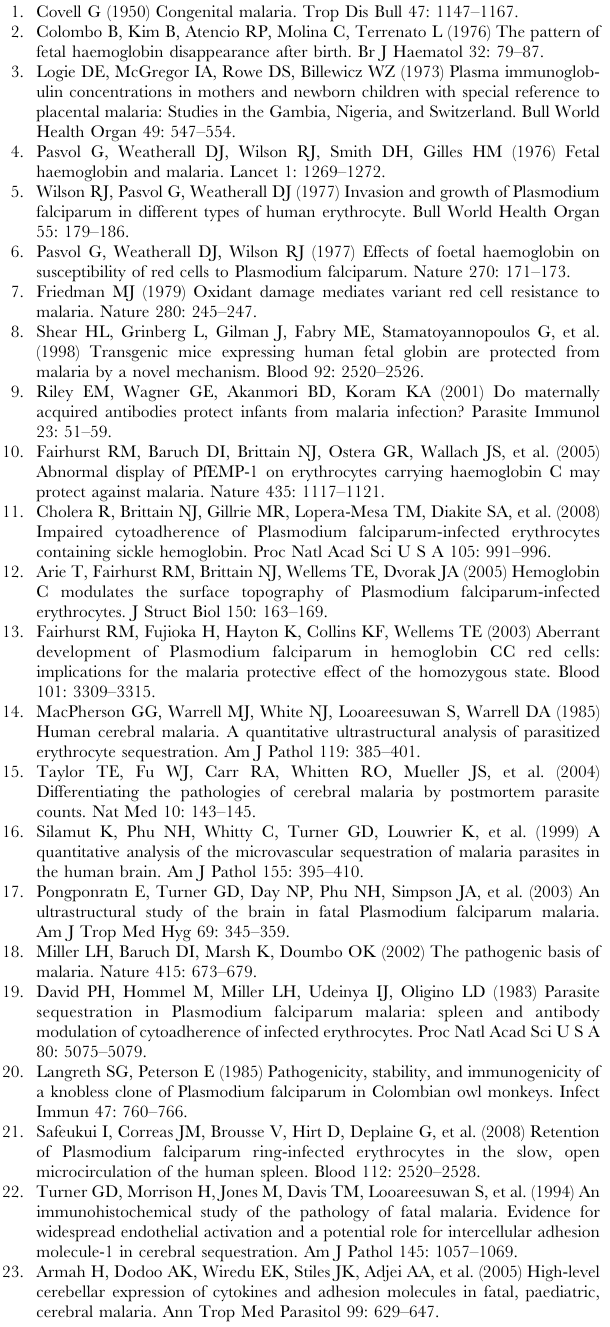
Table S2 Relative adherence of parasitized AA and CB red blood cells (RBCs) to microvascular endothelial cells (MVECs) in the presence of nonimmune IgG (NIgG) or immune IgG (IIgG).